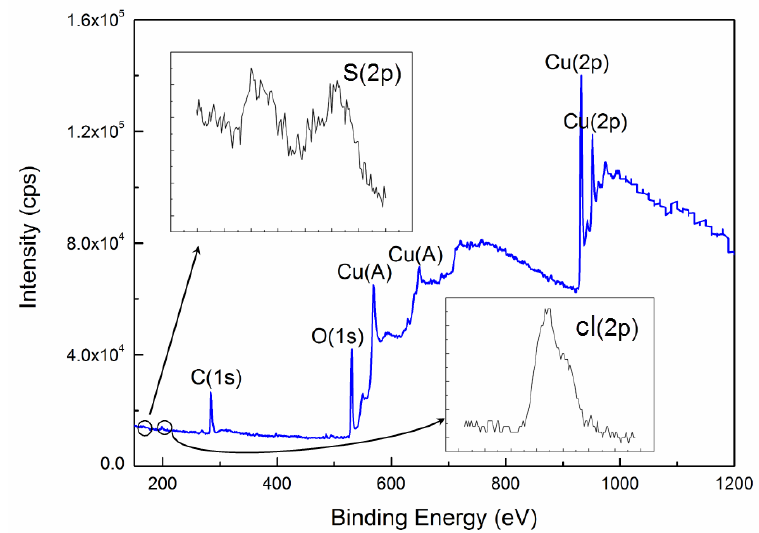
Figure 6. The components of EP Cu substrates by XPS spectra.